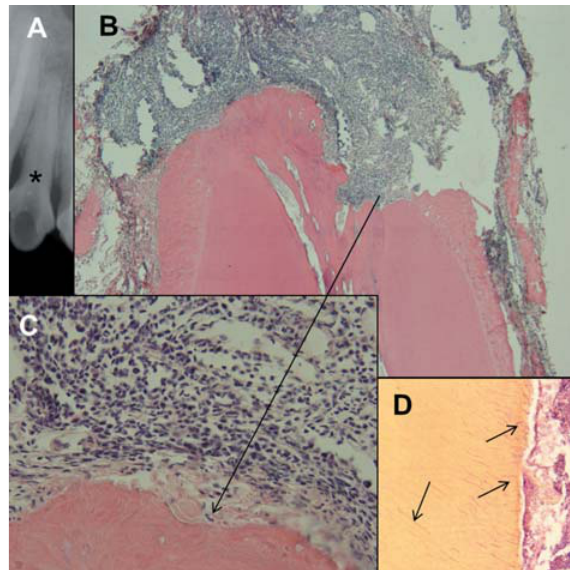
Figure 1- Representative images of the positive control group. (A) Radiographic examination (*) 180 days after pulpectomy [Original; Rx]. (B) Panoramic view [×100; (cid:2)(cid:3)(cid:4)(cid:5)(cid:6)(cid:7)(cid:8)(cid:9)(cid:10)(cid:11)(cid:12)(cid:13) (cid:14)(cid:13) (cid:3)(cid:7)(cid:15)(cid:11)(cid:12)(cid:13) (cid:16)(cid:17)(cid:18)(cid:19)(cid:18)(cid:20)(cid:21)(cid:18)(cid:13) (cid:16)(cid:22)(cid:20)(cid:13) (cid:23)(cid:3)(cid:24)(cid:3)(cid:25)(cid:3)(cid:13) (cid:11)(cid:12)(cid:26)(cid:5)(cid:4)(cid:4)(cid:5)(cid:6)(cid:7)(cid:25)(cid:9)(cid:13) (cid:11)(cid:12)(cid:27)(cid:10)(cid:6)(cid:25)(cid:5)(cid:6)(cid:3)(cid:13)(cid:5)(cid:12)(cid:28)(cid:13)(cid:3)(cid:8)(cid:6)(cid:3)(cid:12)(cid:15)(cid:11)(cid:24)(cid:3)(cid:13)(cid:5)(cid:25)(cid:3)(cid:5)(cid:15)(cid:13)(cid:7)(cid:29)(cid:13)(cid:25)(cid:3)(cid:15)(cid:7)(cid:25)(cid:30)(cid:6)(cid:11)(cid:7)(cid:12)(cid:13)(cid:16)(cid:5)(cid:25)(cid:25)(cid:7)(cid:31)(cid:20)(cid:13)!"#$$%(cid:13) H.E.]. (D) Gram-negative microorganisms in the dentinal tubules (arrows) [×400; Brown and Brenn (B.B.)]